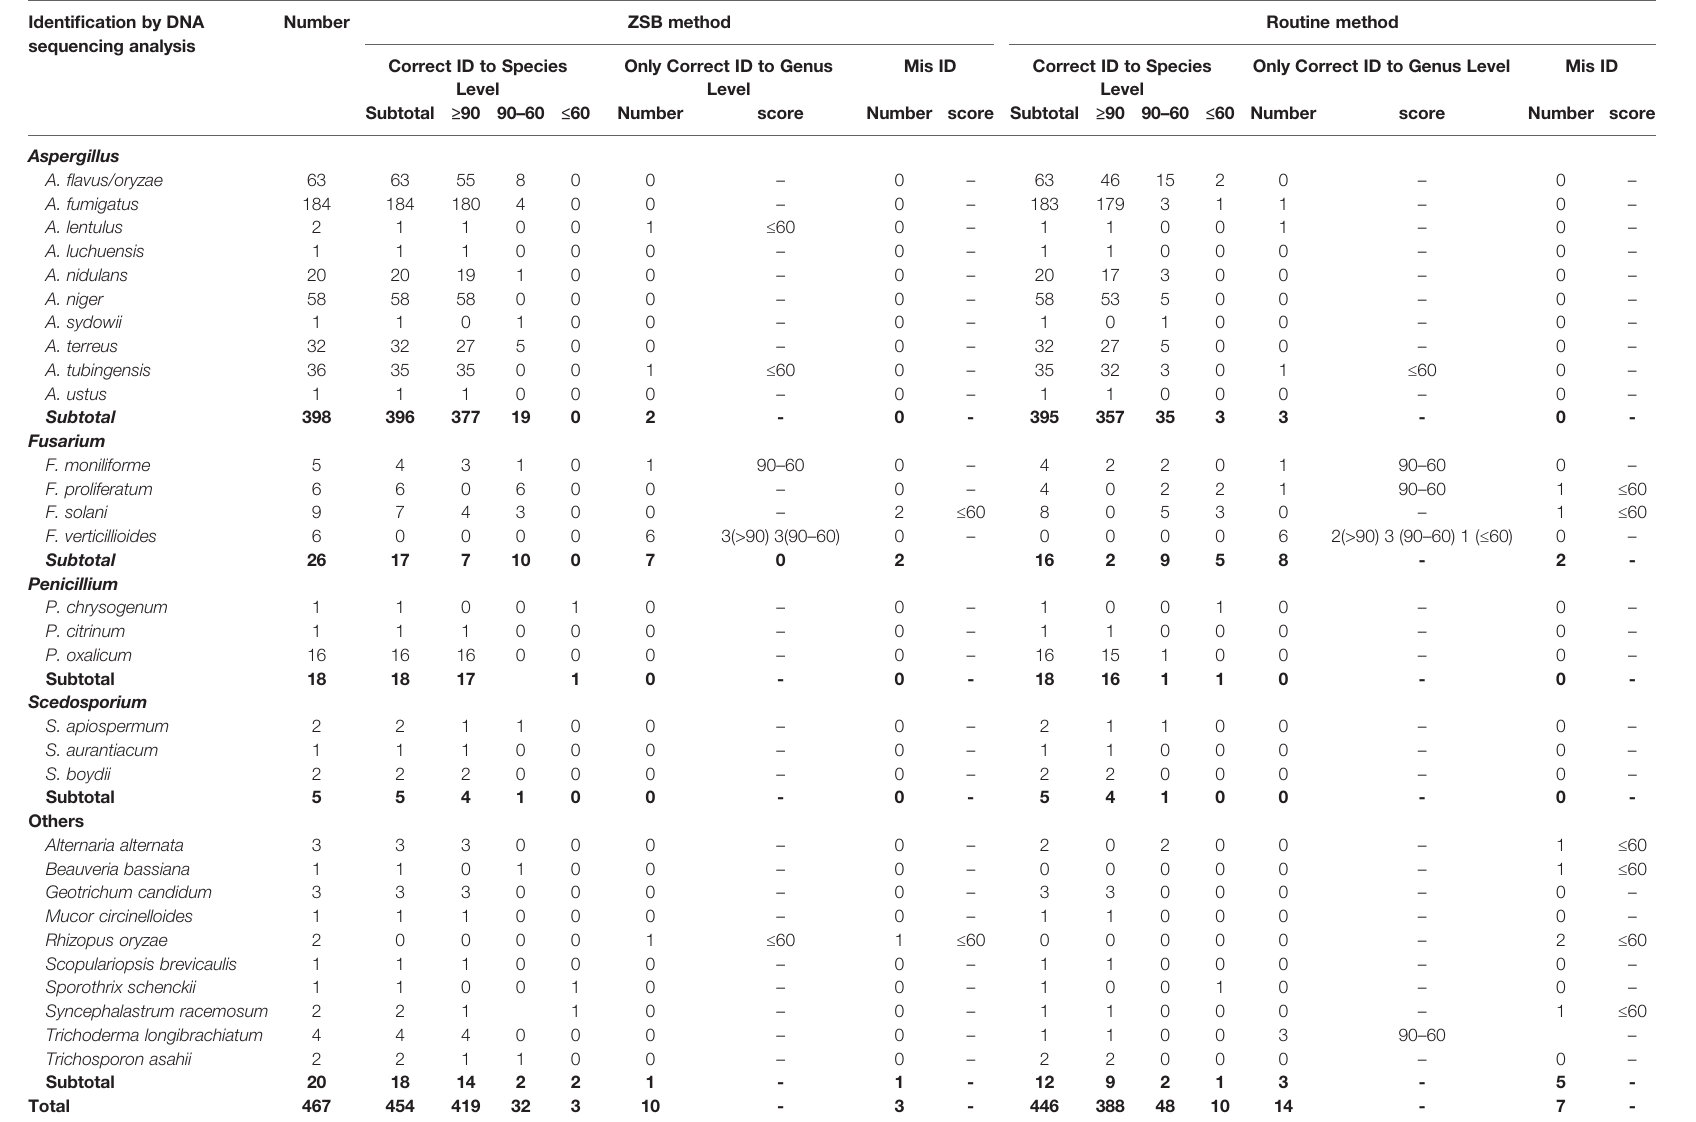
TABLE 3 | 467 clinical fi lamentous fungi isolates identi fi ed by M-Discover 100 MS with the in-house library using the ZSB method in comparison with the routine method. Identi fi cation by DNA sequencing